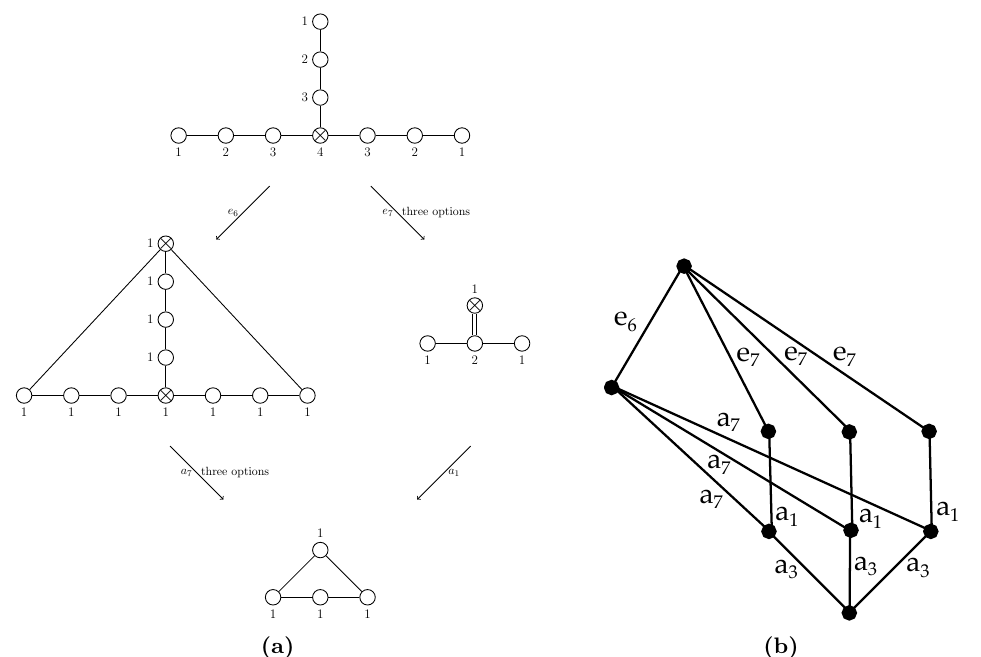
Figure 24 . (a) Subtractions leading to the Hasse diagram of T 4 . We only show one of the three equivalent pathways. (b) The Hasse diagram for T 4